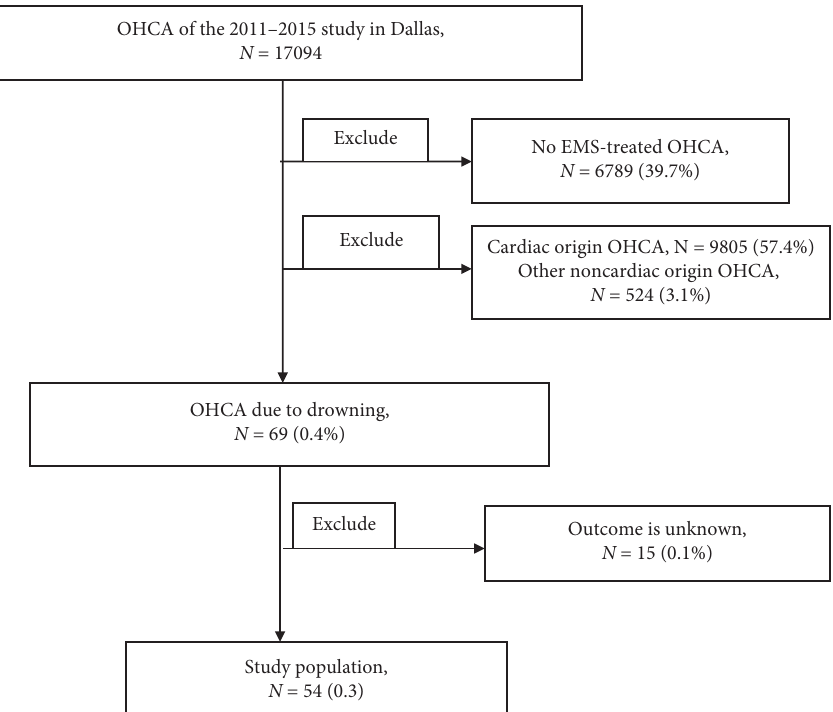
Figure 1: Target cohort and exclusions. OHCA indicates out-of-hospital cardiac arrest; Epistry, Epidemiological Cardiac Arrest Registry; PRIMED, prehospital resuscitation using an impedance valve and early versus delayed analysis; DFW, Dallas–Fort Worth; ROC, Re- suscitation Outcomes Consortium; ROSC, return of spontaneous circulation; ( N ),